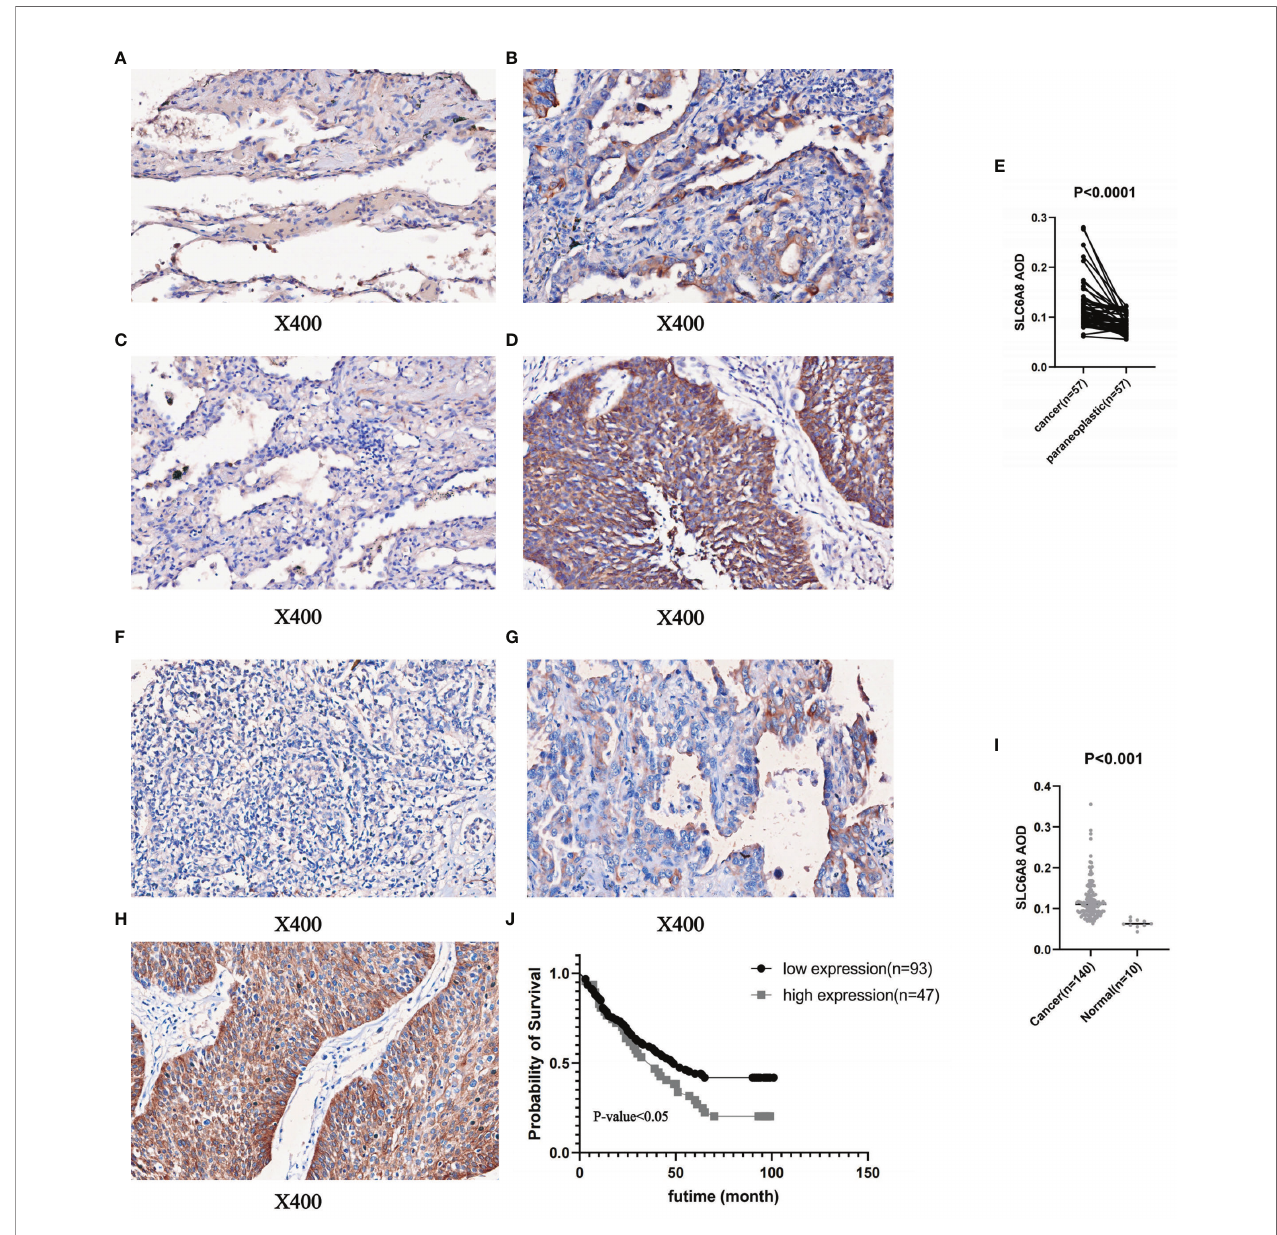
FIGURE 2 | Immunohistochemical staining and quantitative analysis of SLC6A8 expression in NSCLC. (E) Paired differential analysis of SLC6A8 in IMA1 in NSCLC. (A) LUAD paraneoplastic tissue. (B) LUAD tissue (C) LUSC paraneoplastic tissue (D) LUSC tissue (I) Unpaired differential analysis of SLC6A8 in TMA2 in NSCLC (F) Normal tissue (G) LUAD tissue (H) LUSC tissue (J) Survival analysis of SLC6A8 in TMA2 in